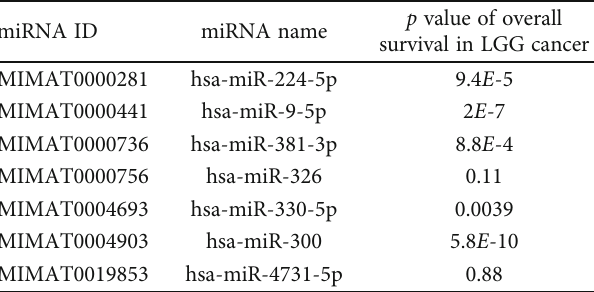
Table 1: miRNA ’ s value of overall survival in brain lower grade glioma (LGG)